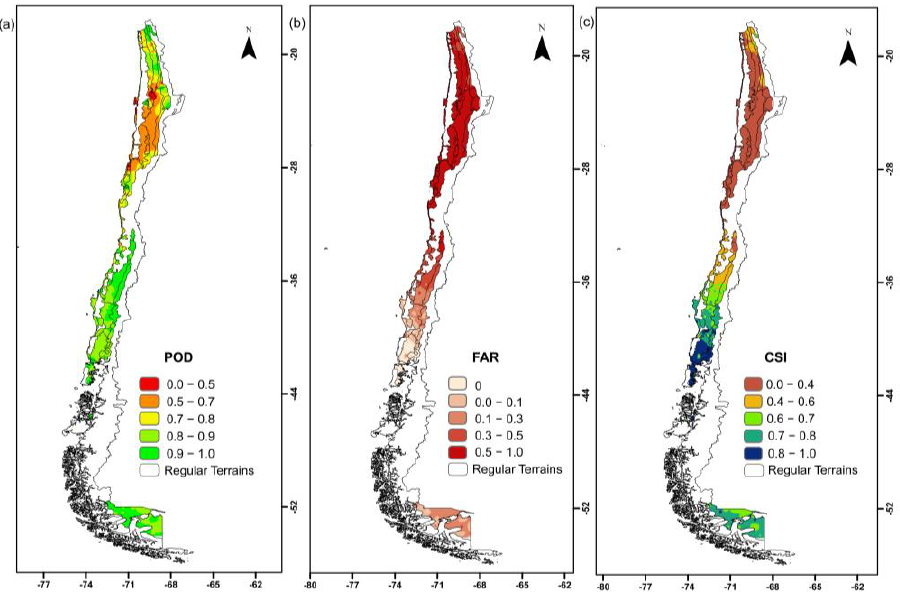
Figure 6. Satellite detection accuracy using ( a ) POD, ( b ) FAR, and ( c ) CSI over the regular terrain’s